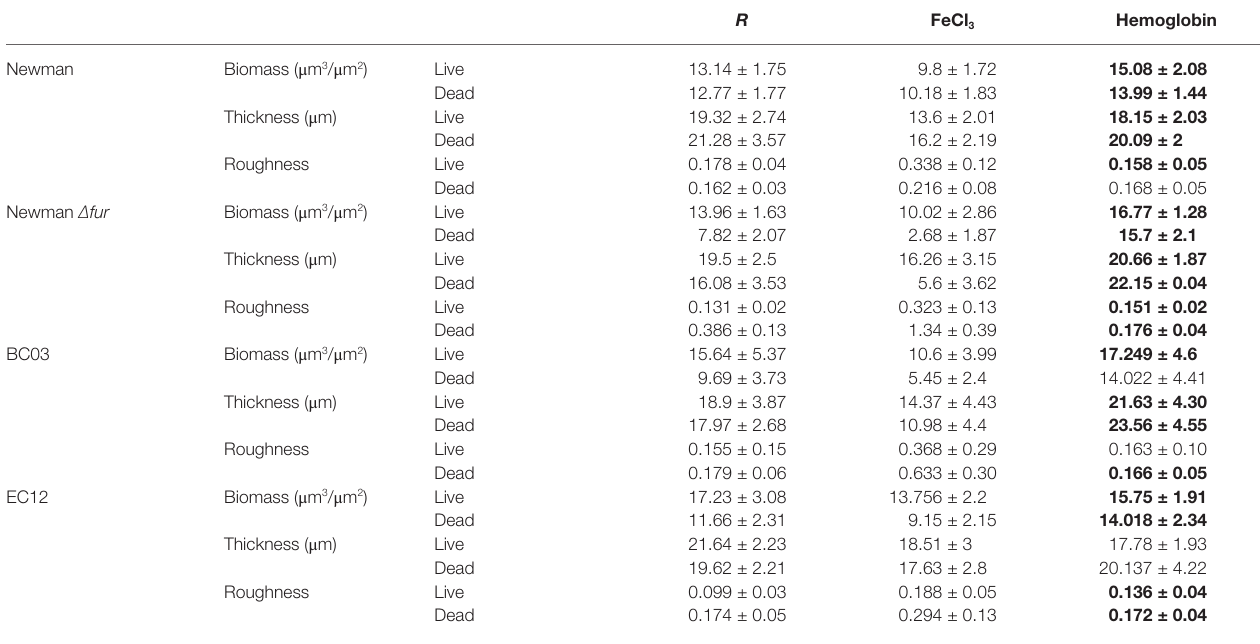
TABLE 1 | Biofilm features estimated by Comstat2. Data is shown as mean and SD from two images of four independent biofilms. Bold numbers denote a significant difference ( p < 0.05) tested by one-way ANOVA and Tukey post-test between iron treatments.